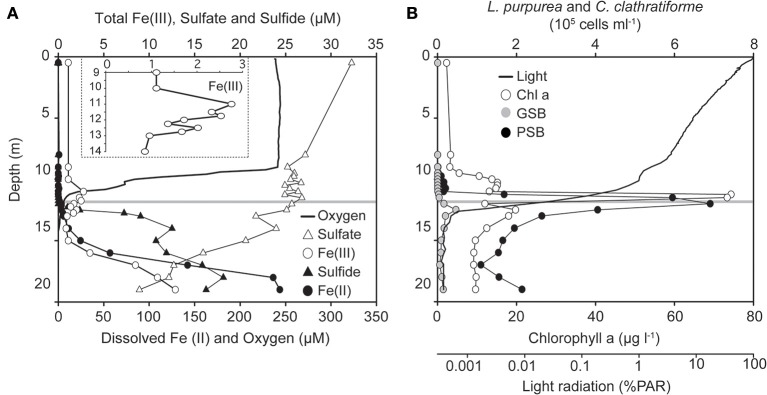
Summer stratification water column data of Lake La Cruz. (A) Chemical stratification at the time when incubation experiments were performed (13/Oct/2008). The insert depicts a magnified Fe(III) concentration profile around the chemocline. (B) Vertical distribution of oxygenic (chlorophyll a concentration, open circles) and anoxygenic phototrophs. Black symbols stand for microscopic cell counts of the dominant purple sulfur bacterium (PSB) Lamprocystis purpurea) and gray symbols for the dominant green sulfur bacterium (GSB) Chlorobium clathratiforme. The horizontal line at 11.8 m indicates the sampling depth for the in situ radiocarbon-incubations and ex situ Fe(II)-oxidation experiments.